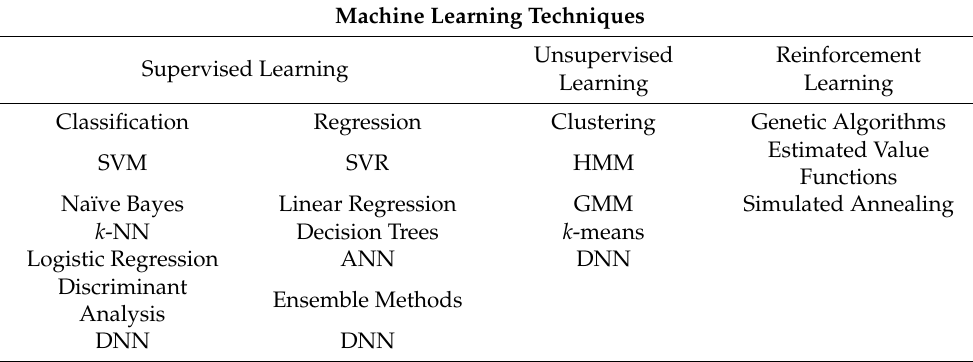
Table 1. Machine learning